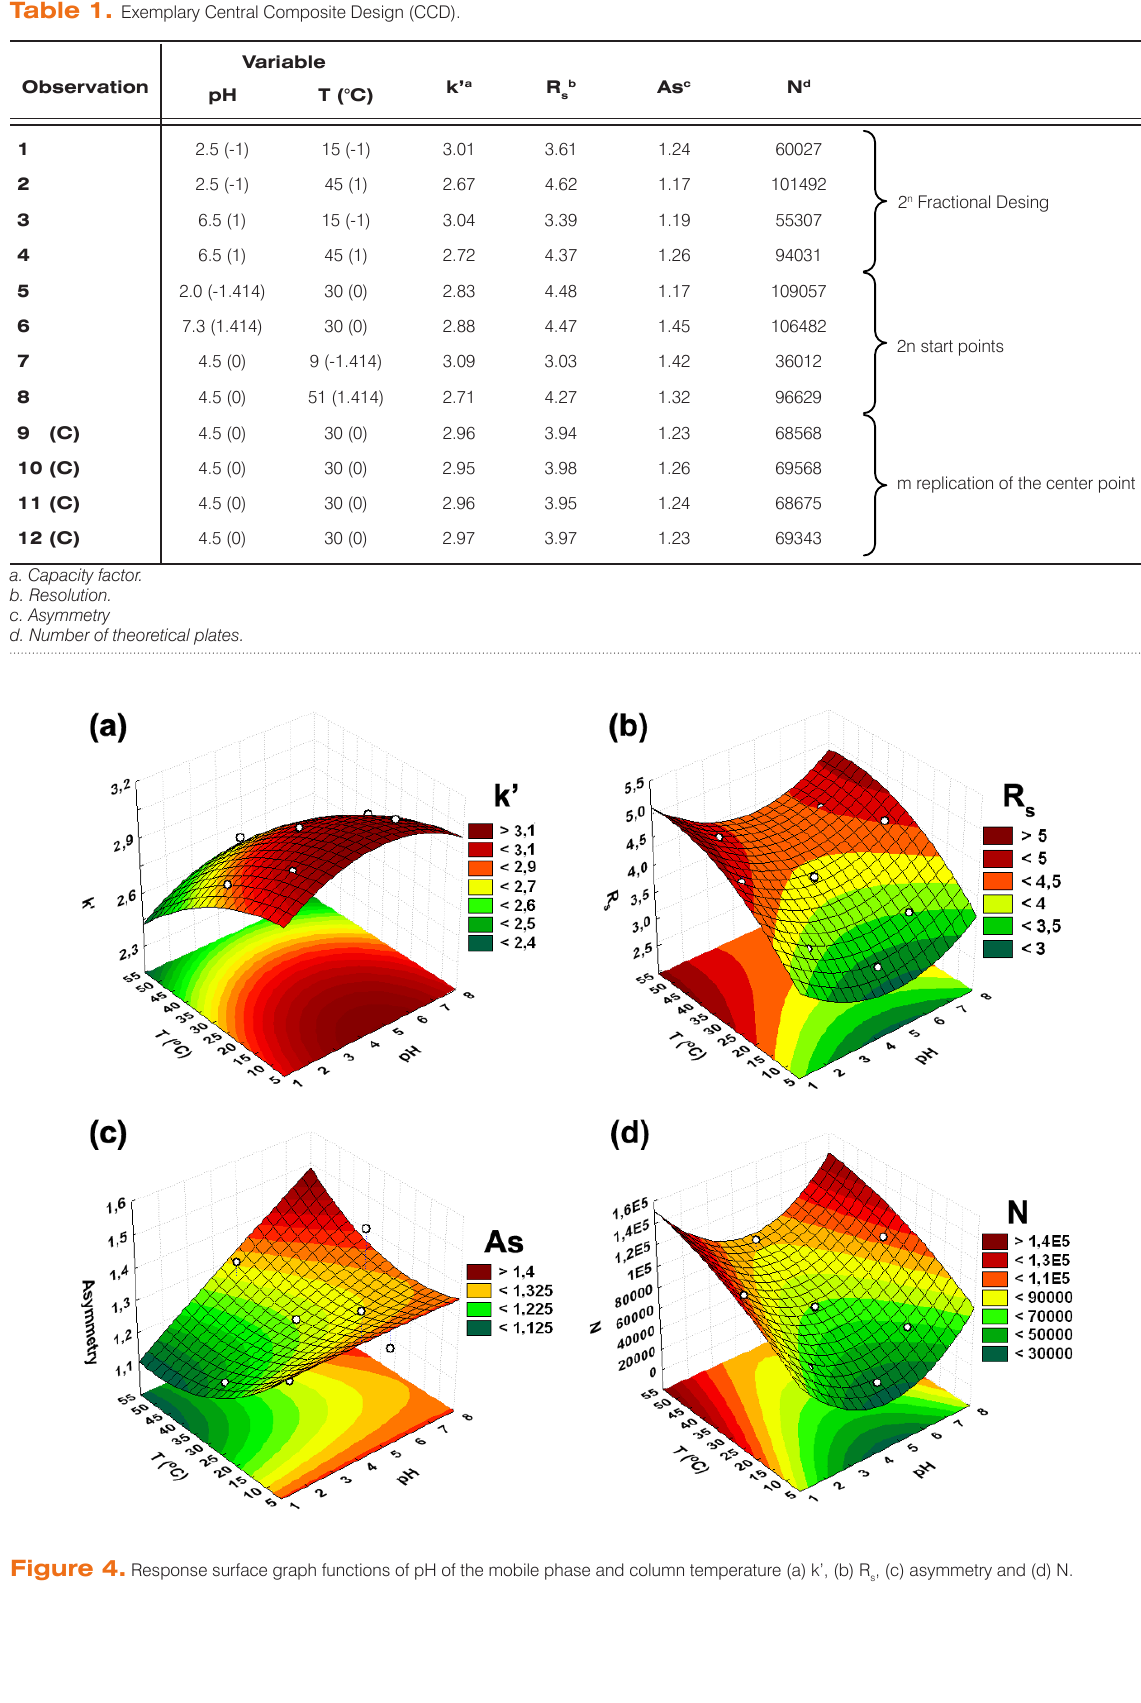
, (c) asymmetry and (d) s